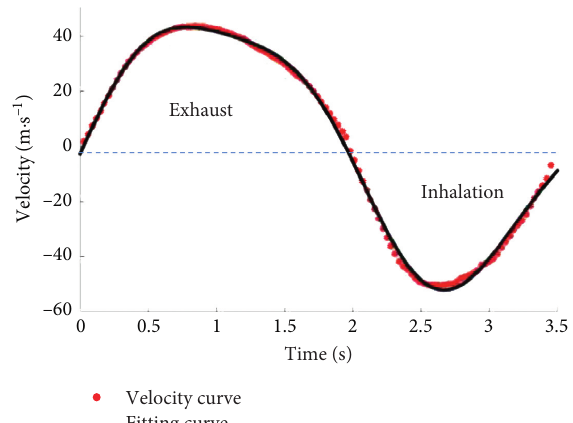
Figure 6: The airflow velocity fitting curve with the oscillation of the OWC.